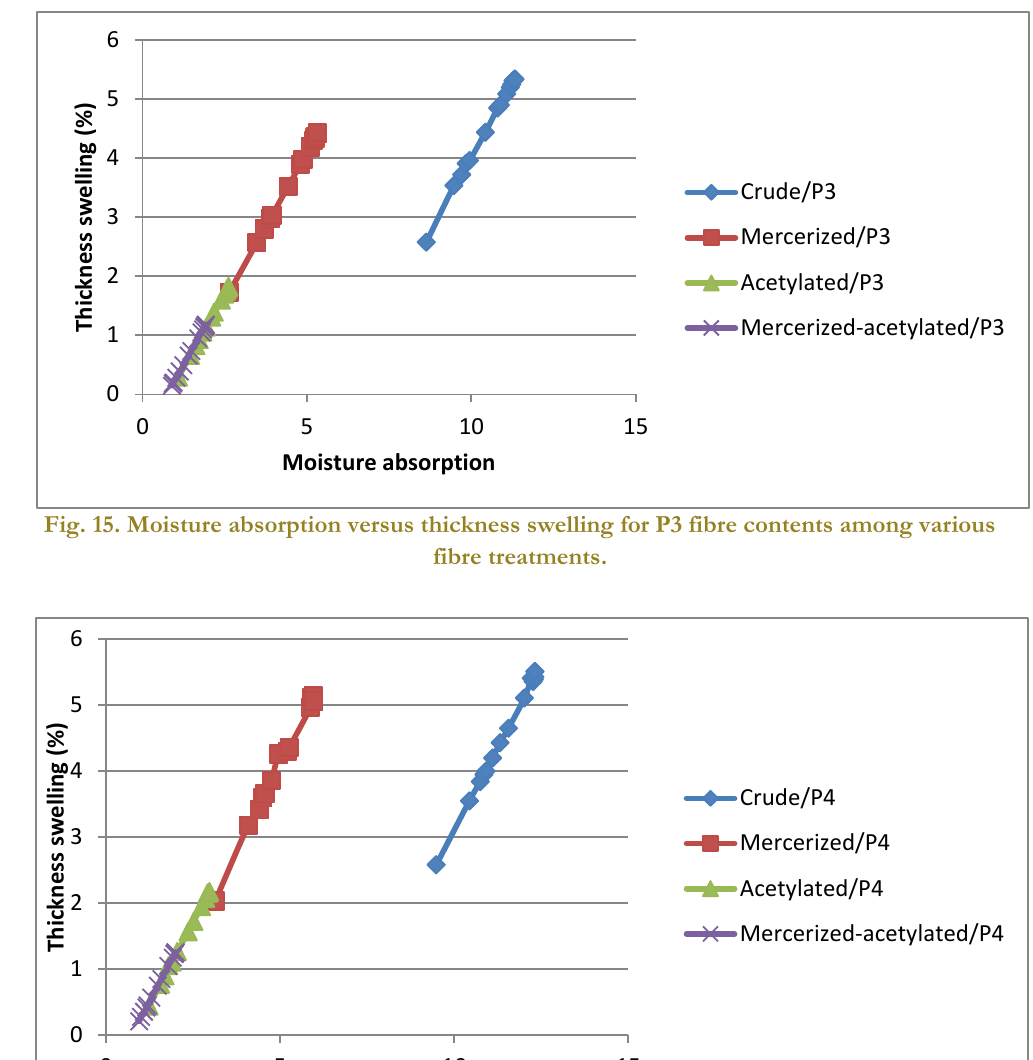
Fig. 14. Moisture absorption versus thickness swelling for P2 fibre contents among various fibre treatments.